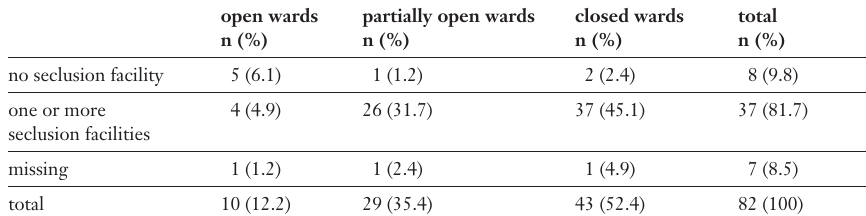
Wards registering coercive measures (n = 82).